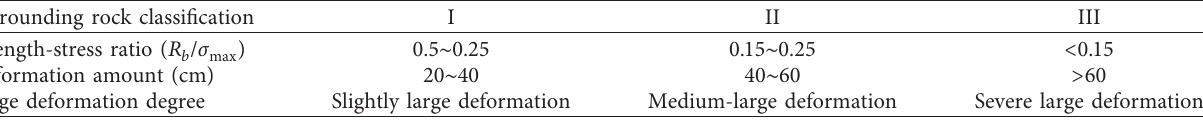
Table 2: Classification standard for large deformation of soft